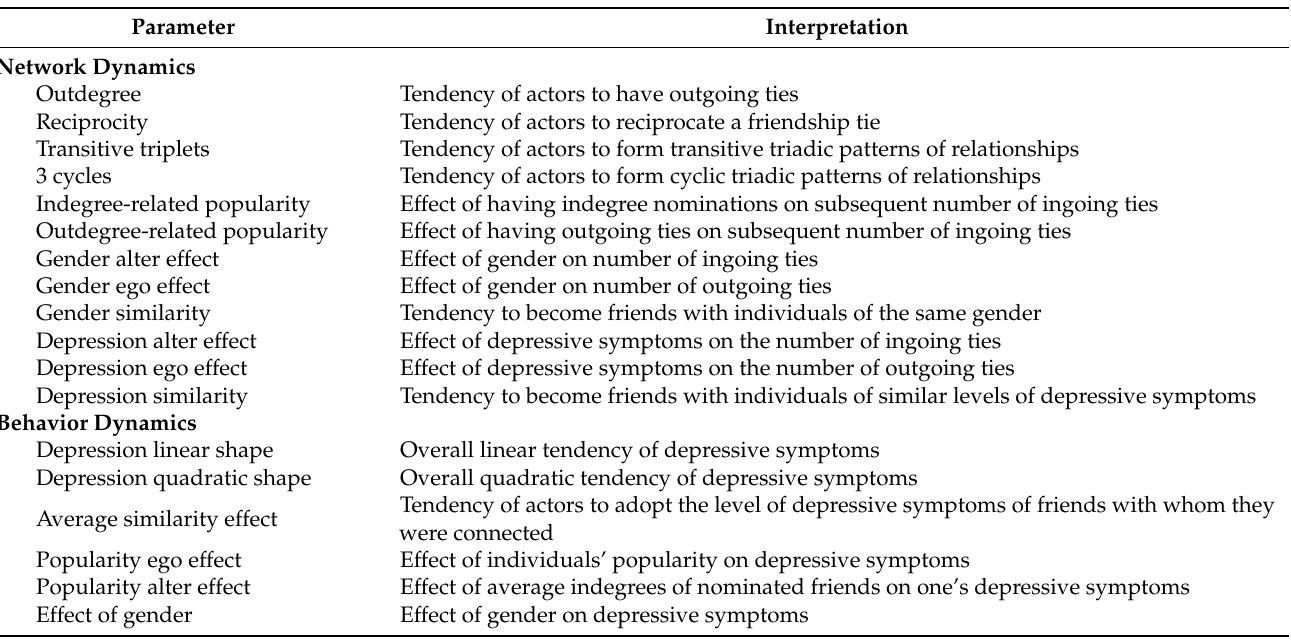
Table 2. Interpretation of the parameters included in the stochastic actor-based model of the peer networks and depressive symptoms of adolescents under chronic